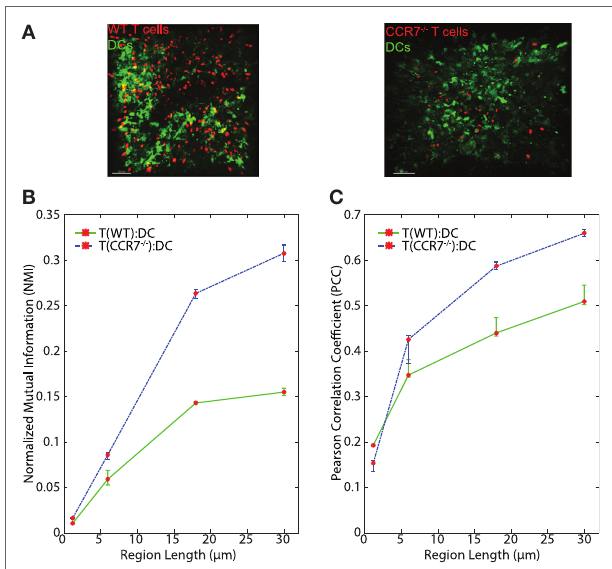
FigUre 6 | (a) Sample images of WT T:DC and CCR7 − / − T:DC. T cells are labeled in red and DCs are labeled in green. In WT T:DC, T cells are wild-type naïve T cells and in CCR7 − / − T:DC, T cells are from CCR7-deficient animals. (B,c) Line plots representing the NMI (B) and PCC (c) of WT T cells and DCs (T(WT):DC, green line) and CCR7 − / − T cells and DCs (T(CCR7 − / − ):DC, blue dashed line). NMI and PCC were calculated on pixels (region length = 1.2 μ m), or regionalized images of increasing side length (6, 18, and 30 μ m). Red stars indicate medians for the corresponding region size, and error bars indicate the 95% confidence interval around the median (40). For NMI, Mann–Whitney p values for T(WT):DC–T(CCR7 − / − ):DC comparisons < e − 4 for all region lengths. For PCC Mann–Whitney p values for T(WT):DC–T(CCR7 − / − ):DC comparisons for region lengths 1.2, 6, 18, and 30 μ m: Region length 1.2 μ m p < e − 4, 6 μ m